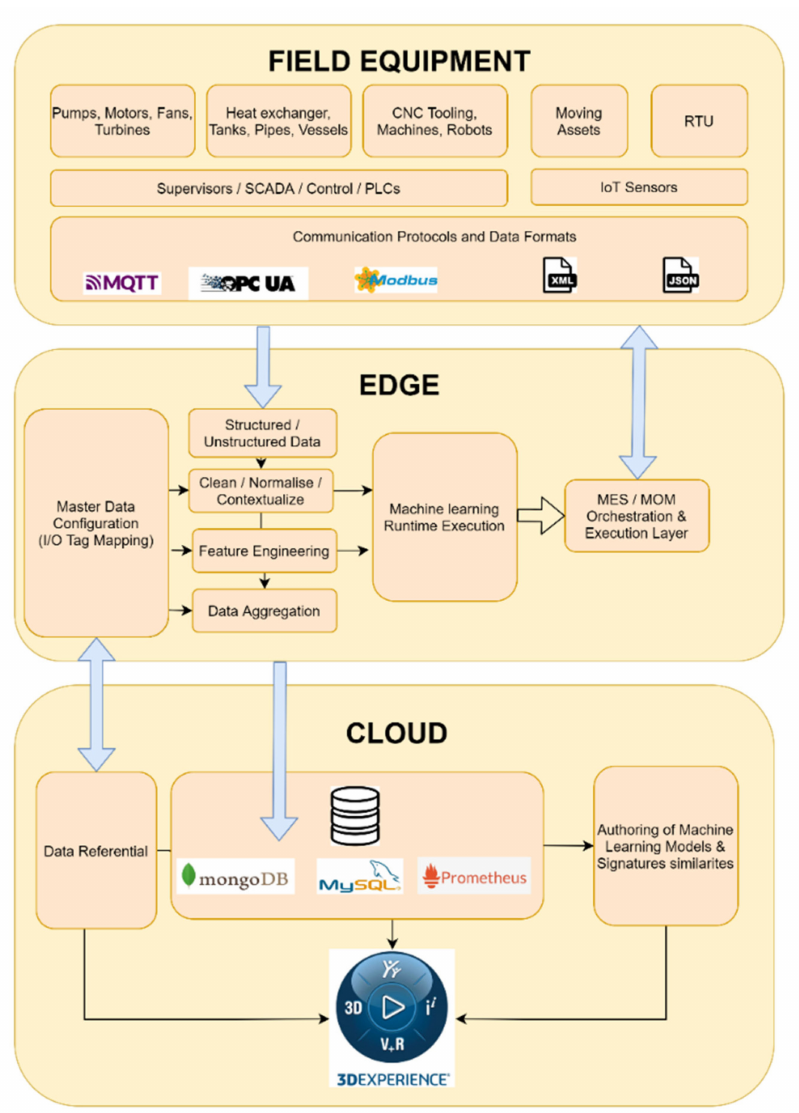
Figure 1. The flow of information between the field equipment, edge and cloud that made up the digital thread concept in industry applications and